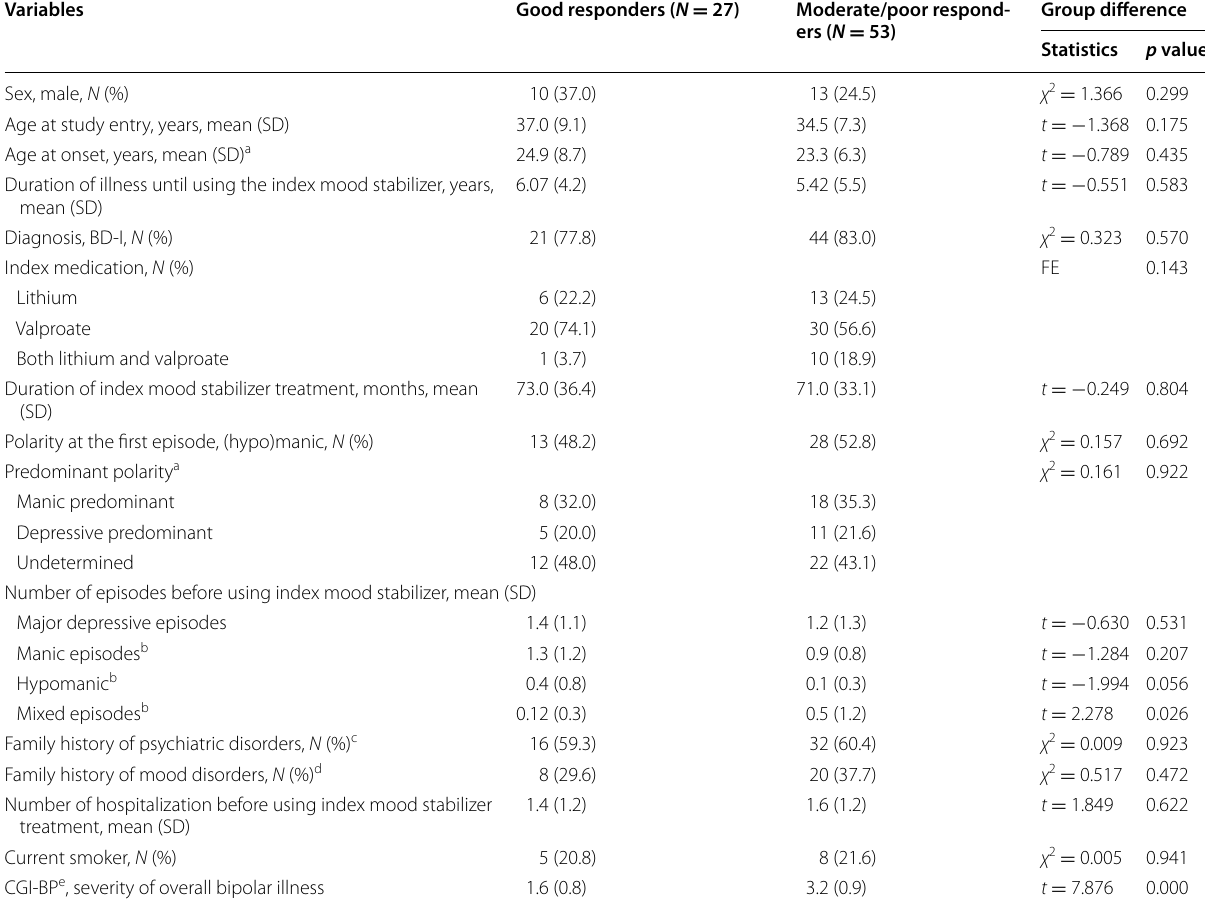
Table 2 Comparison of demographic data and clinical course between good responders and moderate/poor